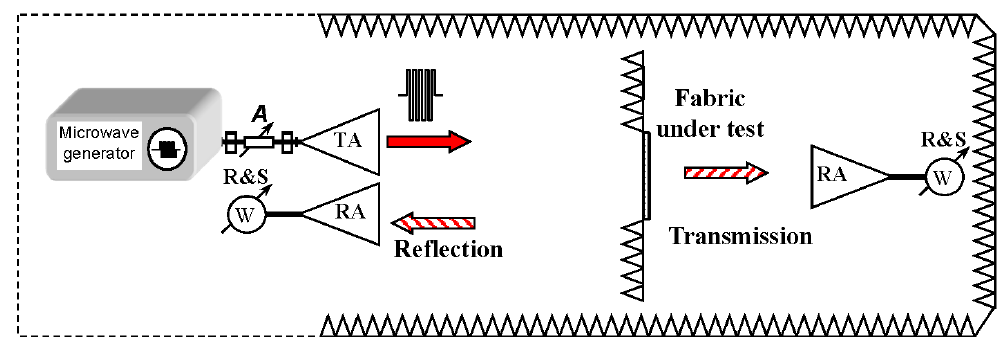
Figure 2. Measurement setup of microwave transmission and reflection from the coated fabric. TA denotes transmitting and RA—receiving antennas.